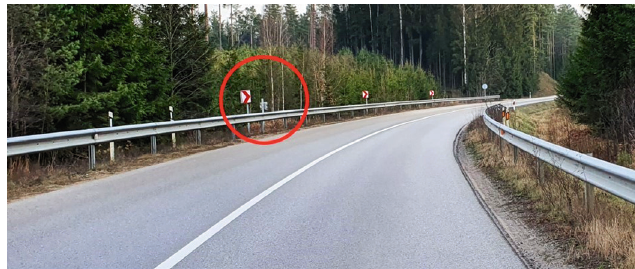
Figure 3. The speed measurement device is mounted in place Site 6 (marked in red